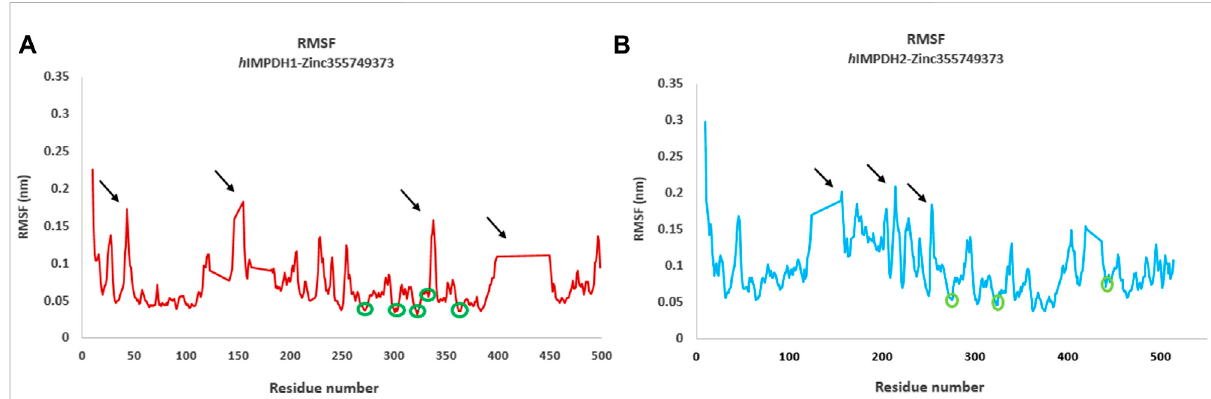
FIGURE 4 Root mean square fl uctuations (RMSF) analysis. RMSF graphs of type 1 (A) and type 2 human IMPDH isoforms (B) in the presence of best hit ligand over 50 ns MDsimulation (monomeric forms).The green circles marked on thediagrams are residues that arehydrogenbondedto theligand atoms. The areas marked with black arrows that have a high RMSF are the residues that are mostly located in the loop